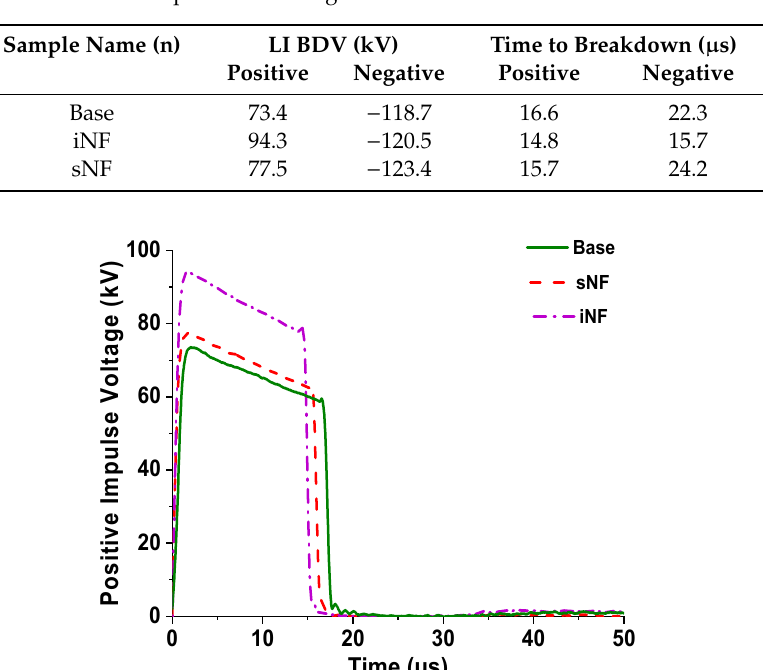
Figure 8. Oscillogram of the positive LI BDVs of the under-study samples at 50% breakdown probability level.